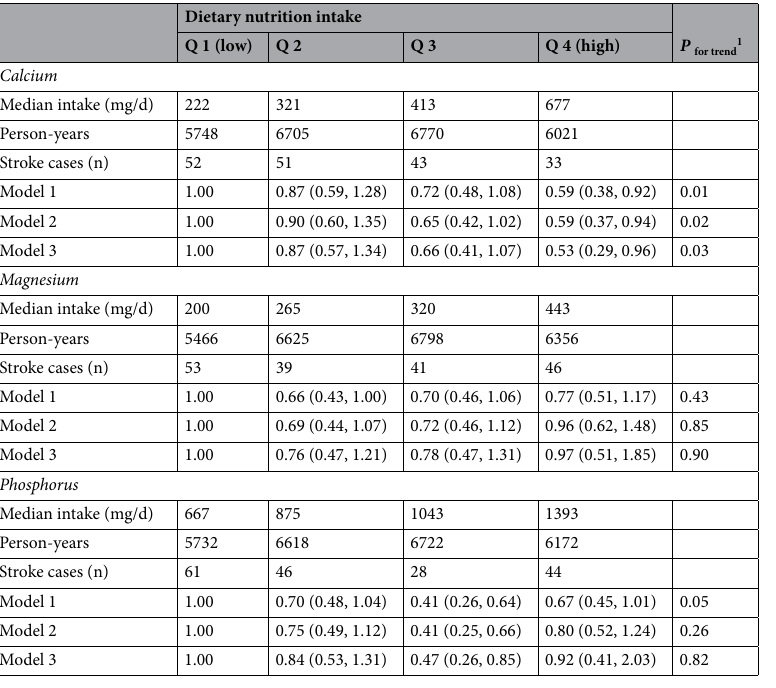
Table 2. Hazard ratios (95% confidence intervals) of stroke according to quartiles of dietary calcium, magnesium, and phosphorus intakes 1 Tests for trend were conducted by modeling the median of each quartile-defined category as a continuous variable in Cox proportional hazards models. Model 1, adjusted for age and sex. Model 2, further adjusted for urbanization index, education, household income, smoking status, alcohol intake, physical activity, BMI, hypertension, diabetes, myocardial infarction, and medication use based on model 1. Model 3, further adjusted for energy, whole grain, red meat, fruits, vegetables, saturated fat, polyunsaturated fat, cereal fiber, Na, K, and cholesterol intakes based on model